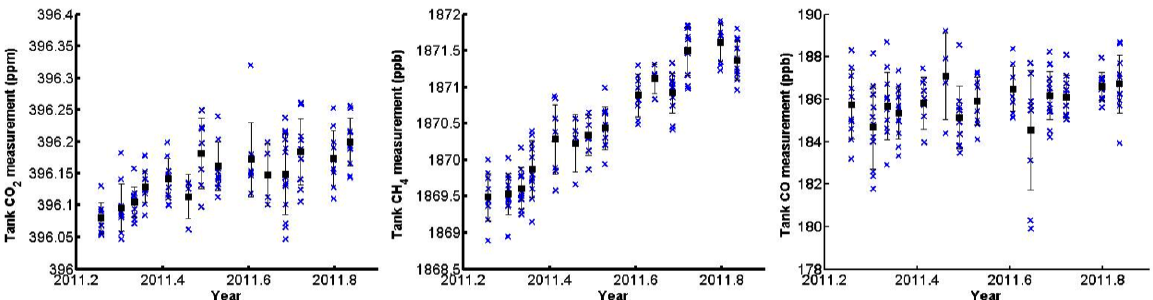
Fig. 7. Measurement of a reference gas tank on the aircraft during flight throughout the 2011 season for CO 2 (left panel), CH 4 (middle), and CO (right). Blue “x” symbols are the mean tank measurement during a single 3-min run; black squares are the average value during a single flight; error bars represent the standard deviation (1 σ ) around that